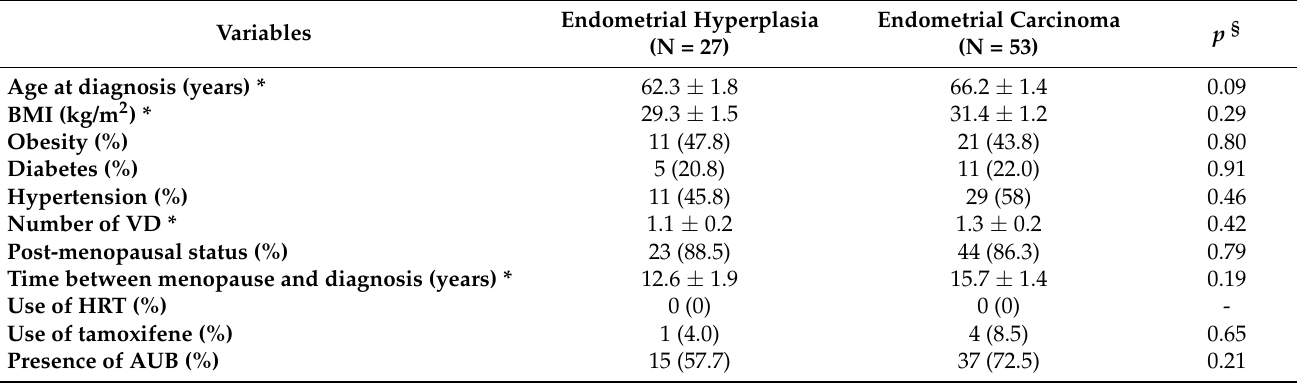
Table 2. Anamnestic features of the study 66.0%) were classified as stage Ia according to FIGO classification [14].